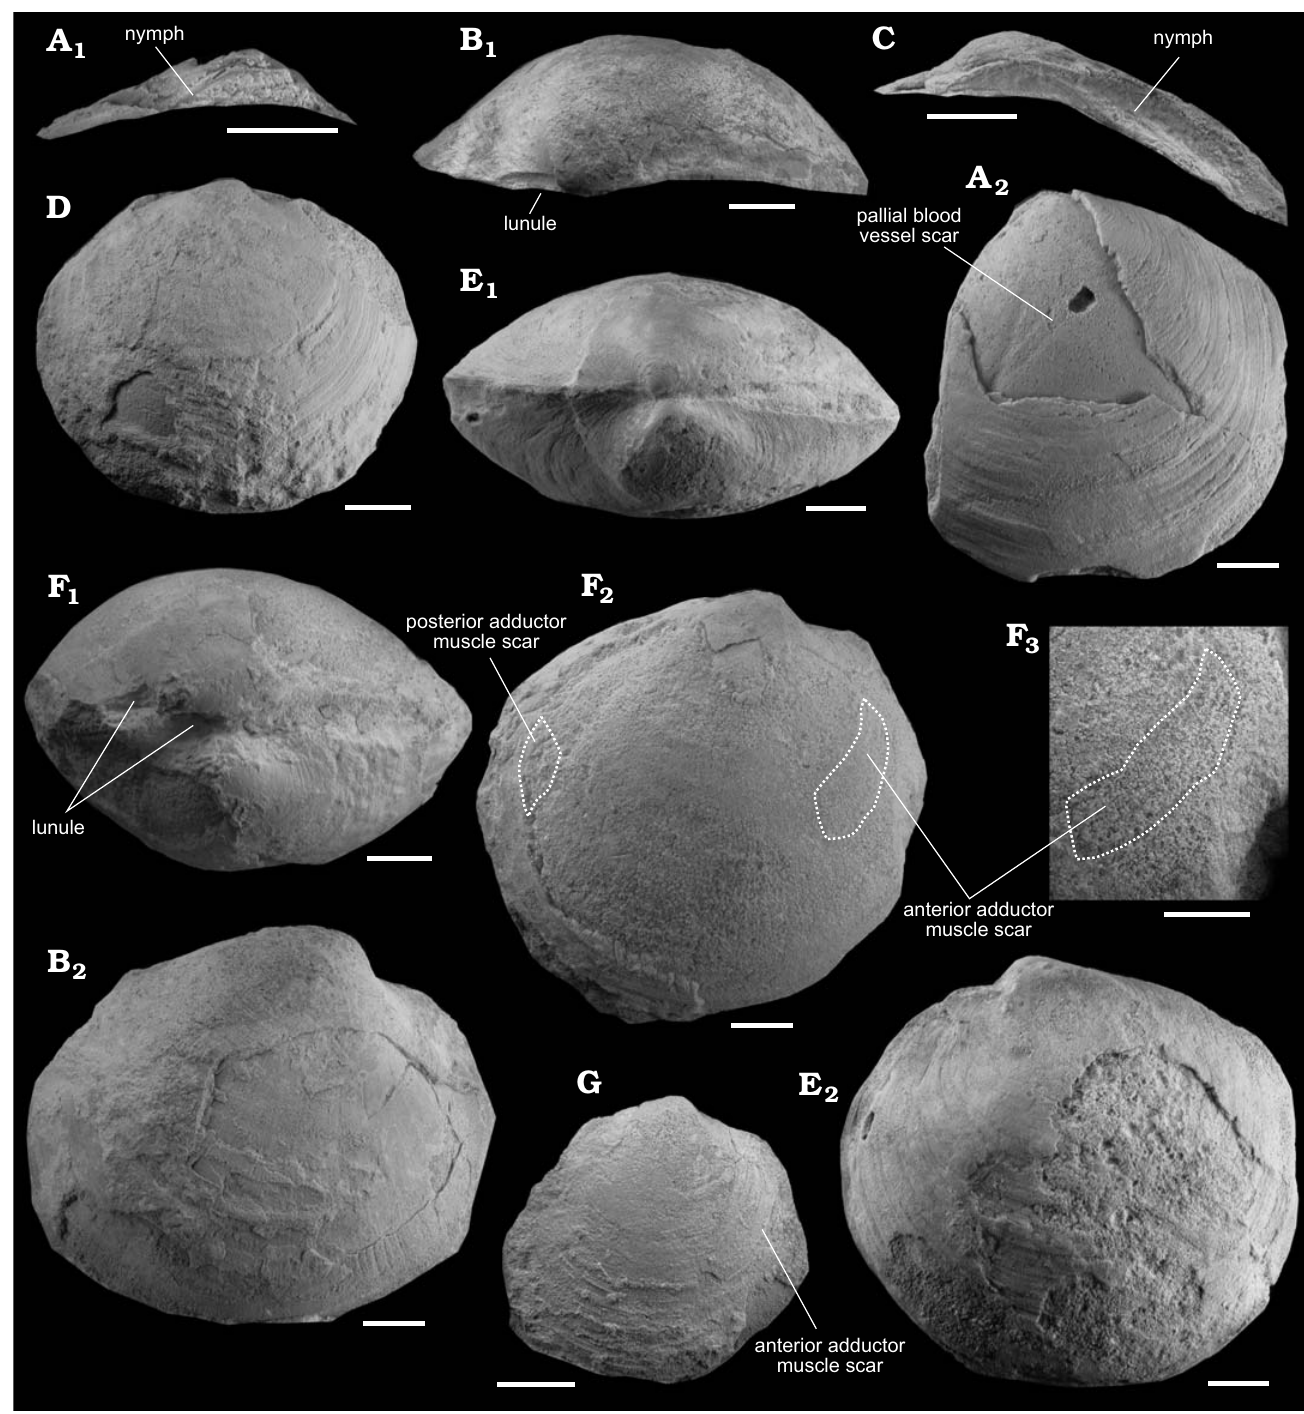
Fig. 3. Lucinid bivalve Meganodontia haunuiensis sp. nov . from the lower Miocene Ihungia Limestone at Haunui (B–G, U23/270) and Ugly Hill (A, U23/280), North Island, New Zealand. A . UOA L4777 (paratype), edentulous hinge plate of left valve (A 1 ,), left valve (A 2 ). B . UOA L4581 (ho- lotype), dorsal view (B 1 ) and frontal view (B 2 ) of right valve. C . UOA L4791 (paratype), edentulous hinge plate of right valve. D . UOA L4790, right valve of small specimen. E . UOA L4782 (paratype), dorsal view of slightly compressed specimen (E 1 ), left valve (E 2 ). F . UOA L4792 (paratype), dorsal view showing symmetric lunule in both valves (F 1 ), right valve showing internal mould (F 2 ), enlargement of the anterior adductor muscle scar of F 2 (F 3 ). G . UOA L 4789, right valve, showing internal mould of small specimen. Scale bars 10